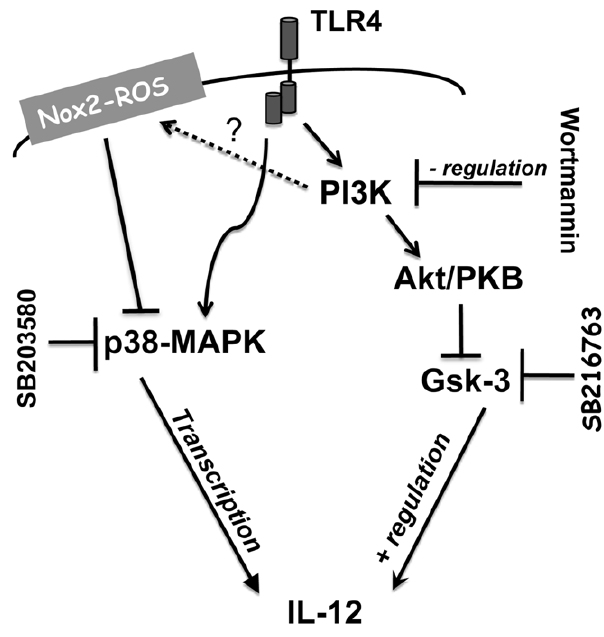
Figure 5. A schematic diagram of the positive and negative regulation of IL-12p70 expression. Nox2-dependent ROS regula- tion of p38-MAPK represses DC IL-12p70 production.